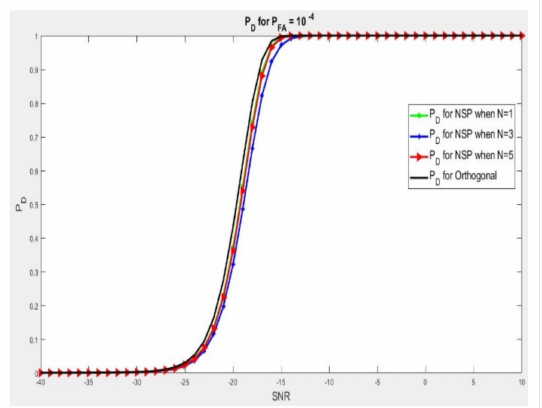
Figure 5. P D at SNR where P f = 10 − 4 and massive radar lessens disturbance in the network at all the base stations where M = 100, Ҡ = 4, and N =